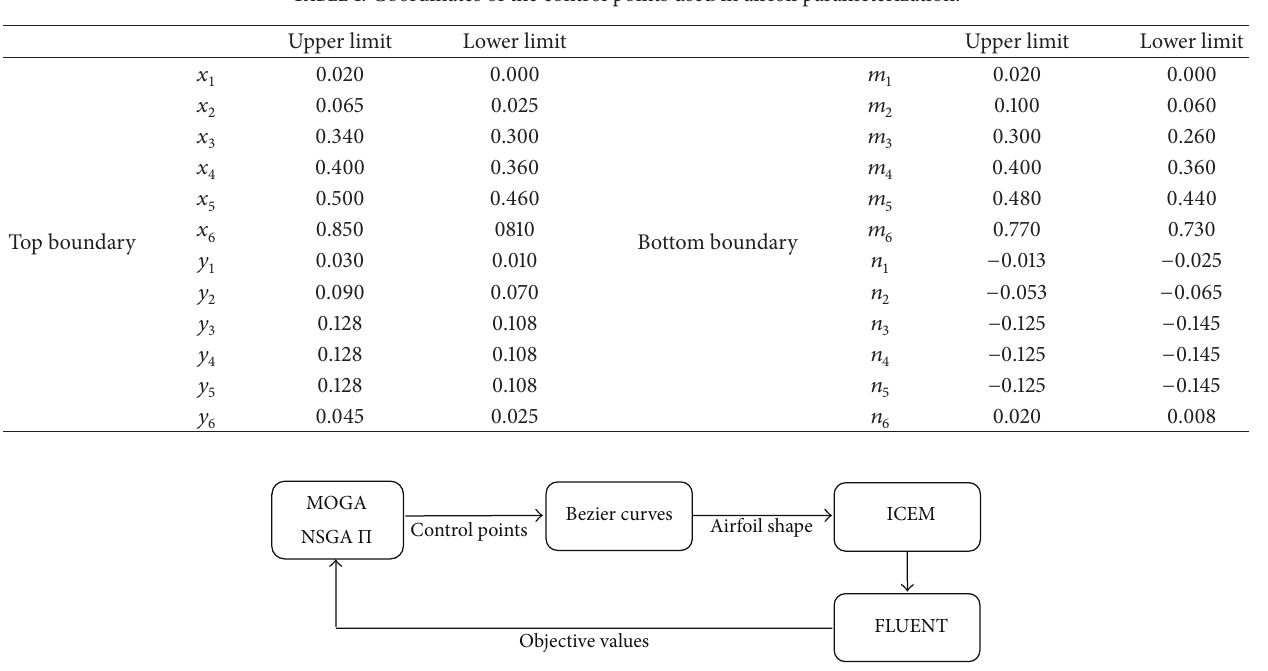
Table 1: Coordinates of the control points used in airfoil parameterization.